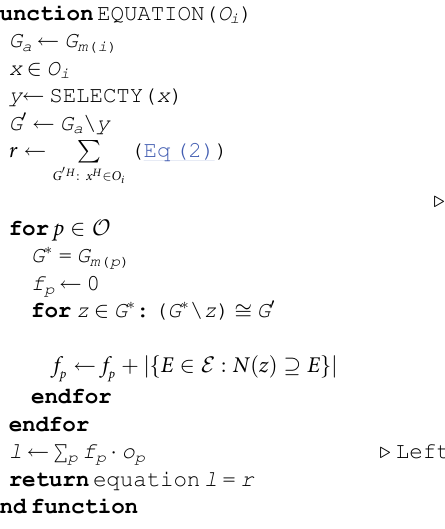
Algorithm 1 Derive an equation for orbit O